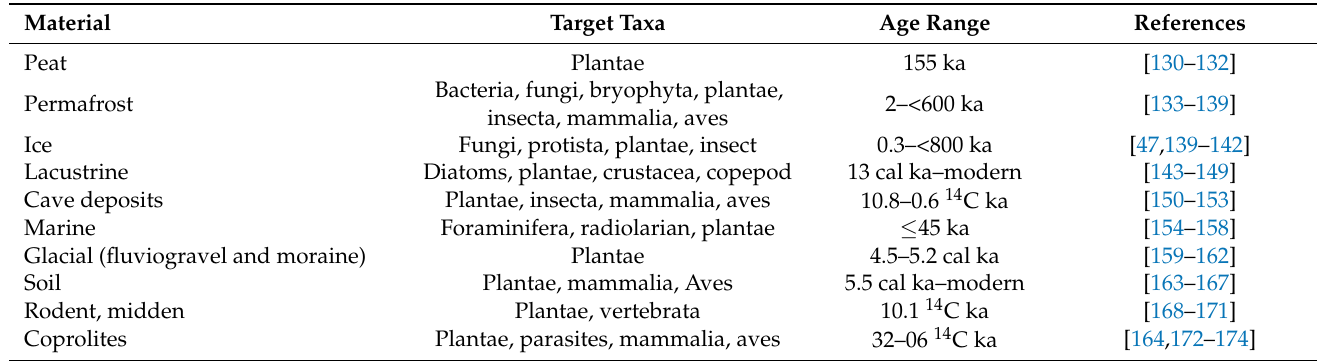
Table 4. A sample of research publications that focused on the congruency between eDNA and